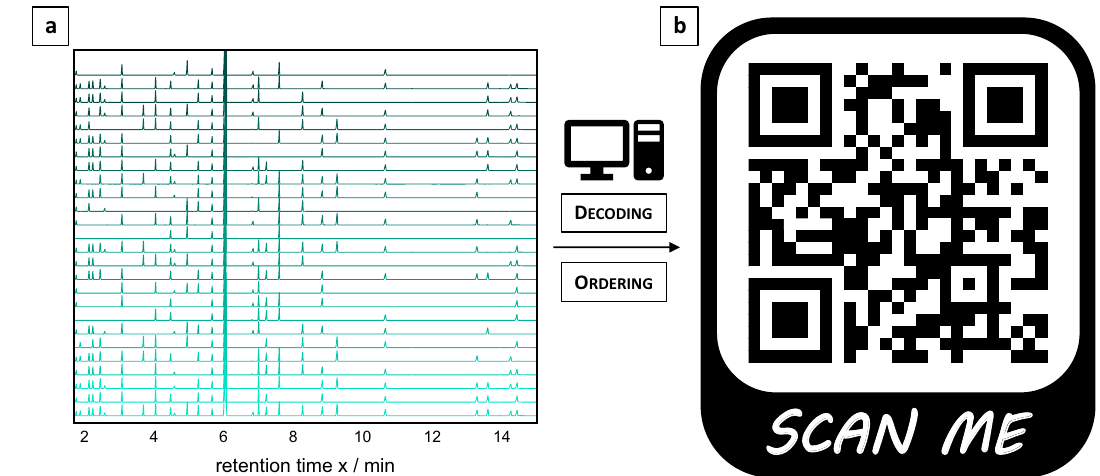
Figure 3. Schematic representation of QR coding. ( a ) Randomly ordered GC chromatograms of information- containing samples plus reference chromatogram containing all compounds. ( b ) Bitmap of a 25 × 25-pixel QR code containing 625 bits of information. Encoding was achieved via GC in 25 mixtures using 25 information compounds (25 bits) plus two reference molecules and a reference sample containing all molecules. Decoding was performed manually and using a new decoding software. The QR leads to the homepage of the KIT (https:// www. kit. edu/ index.